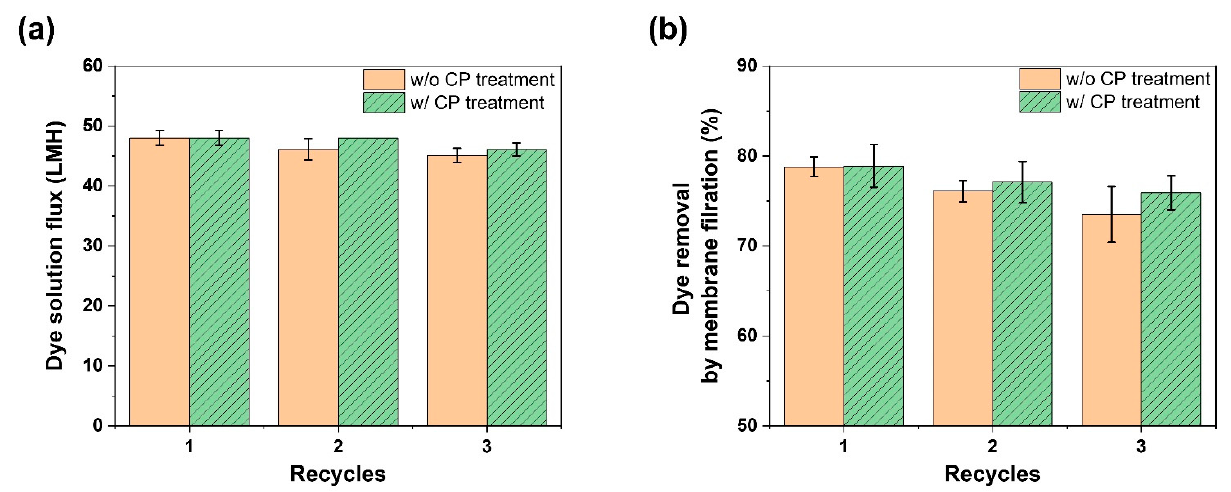
Figure 4. ( a ) Dye solution flux and ( b ) dye removal efficiency by membrane filtration ( n = 3).